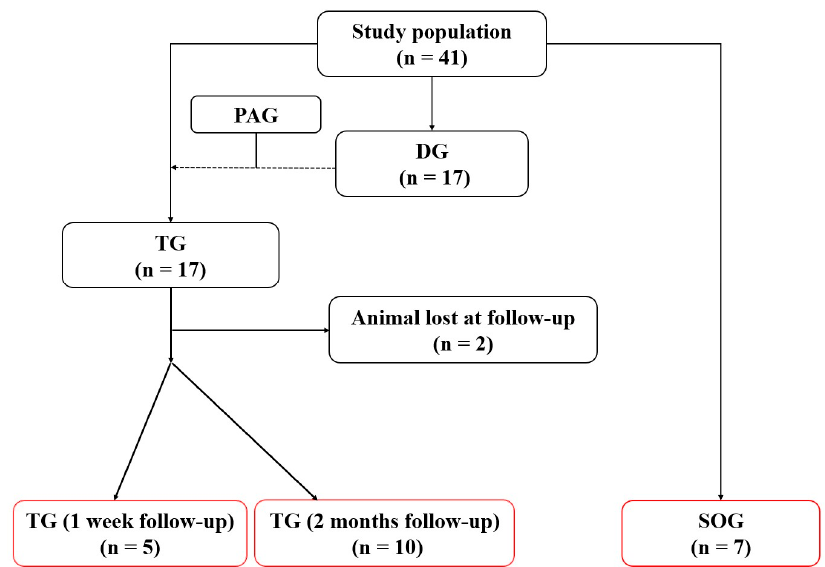
Figure 1. Flowchart of the study, showing the three groups and their numerosity. DG: donor group; PAG: pulmonary artery graft; SOG: sham-operated group; TG: transplant group.